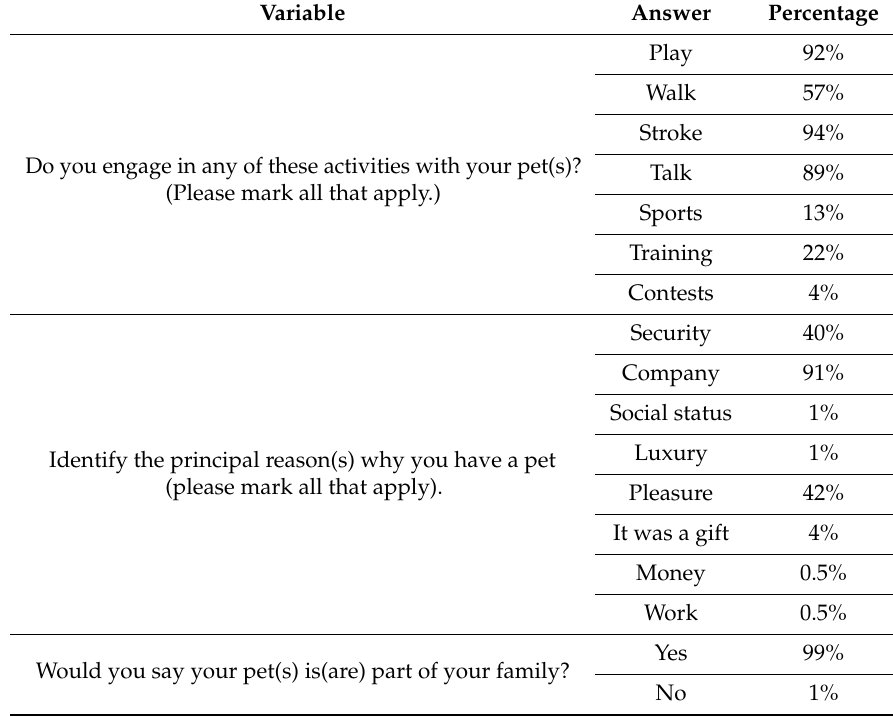
Table 4. Human–animal companion